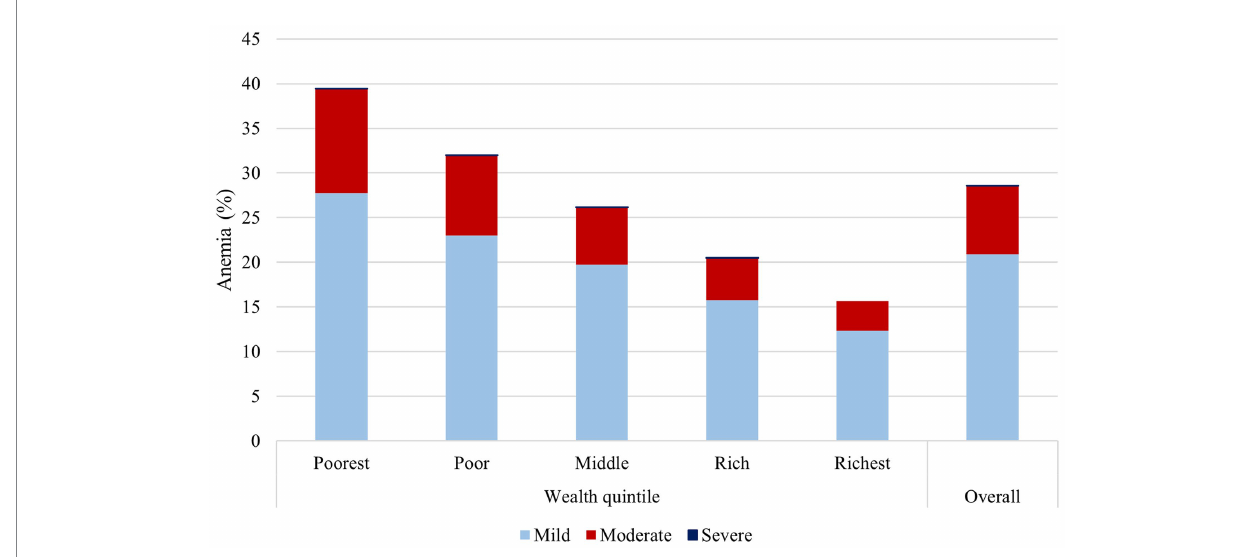
FIGURE 2 Severity of anemia according to wealth index in Peruvian children.